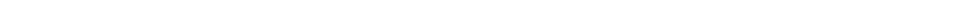
(see fi gure on previous page) Fig. 6 RGMa activates microglia morphologically. A Schematic representation of the timeline of AAV injection, intraperitoneal minocycline administration, and behavioral tests. The white arrowhead indicates the time point of AAV injection; the black arrowhead indicates the time point of the behavioral tests. B Representative images of the immuno fl uorescent staining for TH in the SN at 5 weeks after AAV injection. Scale bar, 200 μ m. C Changes in the numbers of TH-positive cells in the SN of AAV-injected mice with saline or minocycline treatment at 5 weeks after AAV injection. n = 5 – 6. * P < 0.05, one-way ANOVA with Bonferroni multiple comparison test. D Representative images of microglia in the SN of Cx3xr1CreERT2; Ai14 mice 5 weeks after AAV injection with or without minocycline treatment. Scale bar, 100 μ m. E Changes in the numbers of CX3CR1-positive microglia in the SN of AAV-injected mice with saline or minocycline treatment at 5 weeks after AAV injection. n = 6. F Representative images of microglial morphology in the SN of Cx3xr1CreERT2; Ai14 mice 5 weeks after AAV injection with or without minocycline treatment. Scale bar, 10 μ m. G Tracing image of microglia by Imaris. Microglia changed to an activated form by overexpression of RGMa 5 weeks after AAV injection. Scale bar, 30 μ m. H Results of sholl analysis. Microglia of mice overexpressed RGMa had shortened processes near the cell body. Minocycline treatment improved the number and length of processes. n = 5 – 6. I – K Measured values of microglial morphology. In AAV-TH-RGMa treated group, the length of microglial processes ( I ), the numbers of branch point ( J ), and processes ( K ) were signi fi cantly reduced, and administration of minocycline suppressed